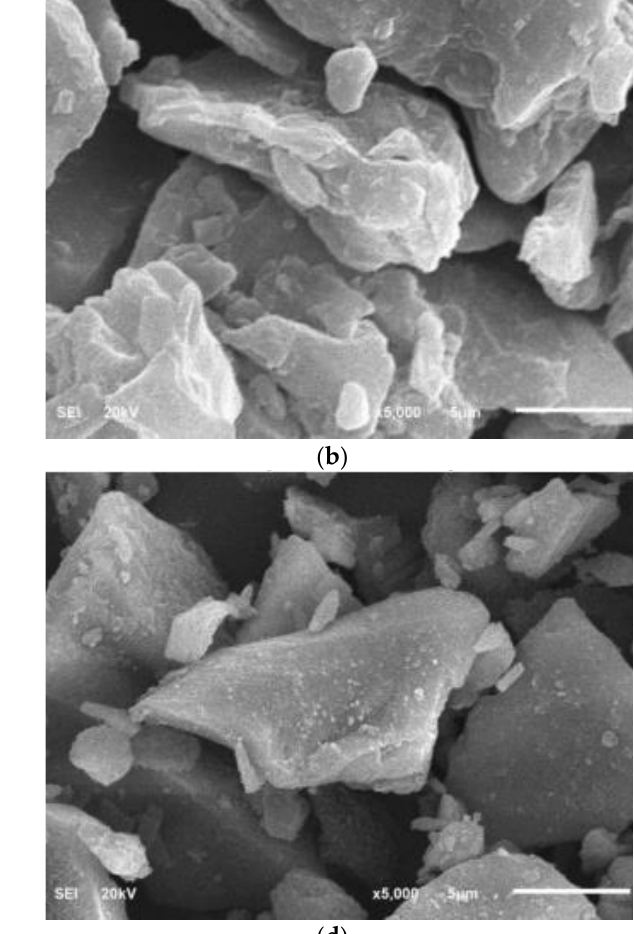
Figure 6. Particle size distributions of DKA, FA, and NP.